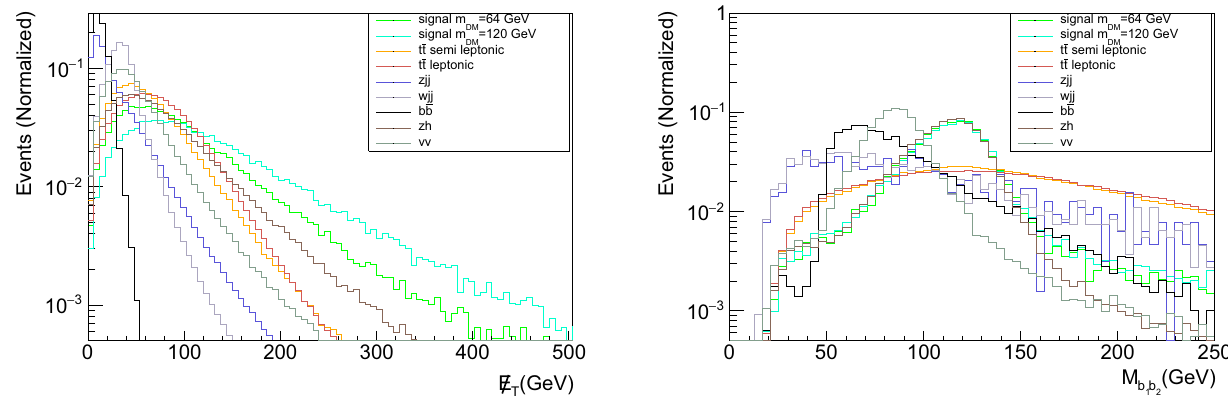
Fig. 13 Normalized distributions of / E T (left) and invariant mass of leading and sub-leading (right) b jets